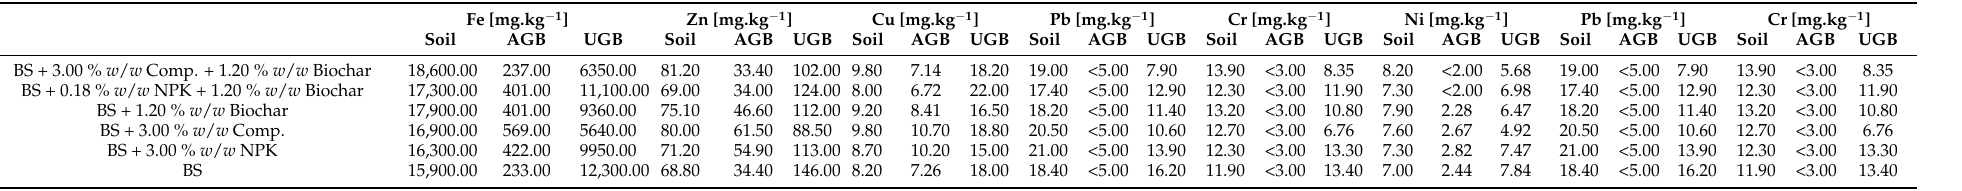
Table 5. Mean concentration of Fe and Zn in soil, AGB, and UGB